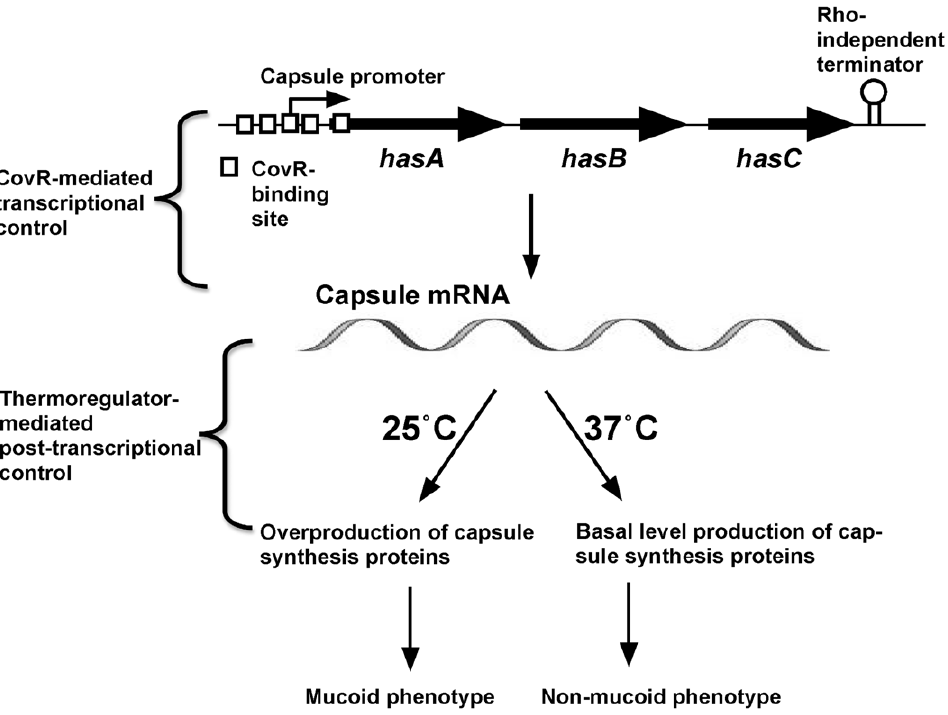
Figure 5. Regulation of capsule production by S.pyogenes strains, HSC5 and MGAS315. Capsule production by the non-mucoid S. pyogenes strains, HSC5 and MGAS315, is regulated both at the transcriptional and post-transcriptional level. Phosphorylated CovR binds to its binding sites in the capsule promoter region, and represses hasABC transcription [45]. A thermoregulatory system regulates the production of capsule synthesis proteins at a post-transcriptional level. Capsule production occurs only when CovR is not bound to the hasABC promoter region and environmental temperature is lower than 37 u C.